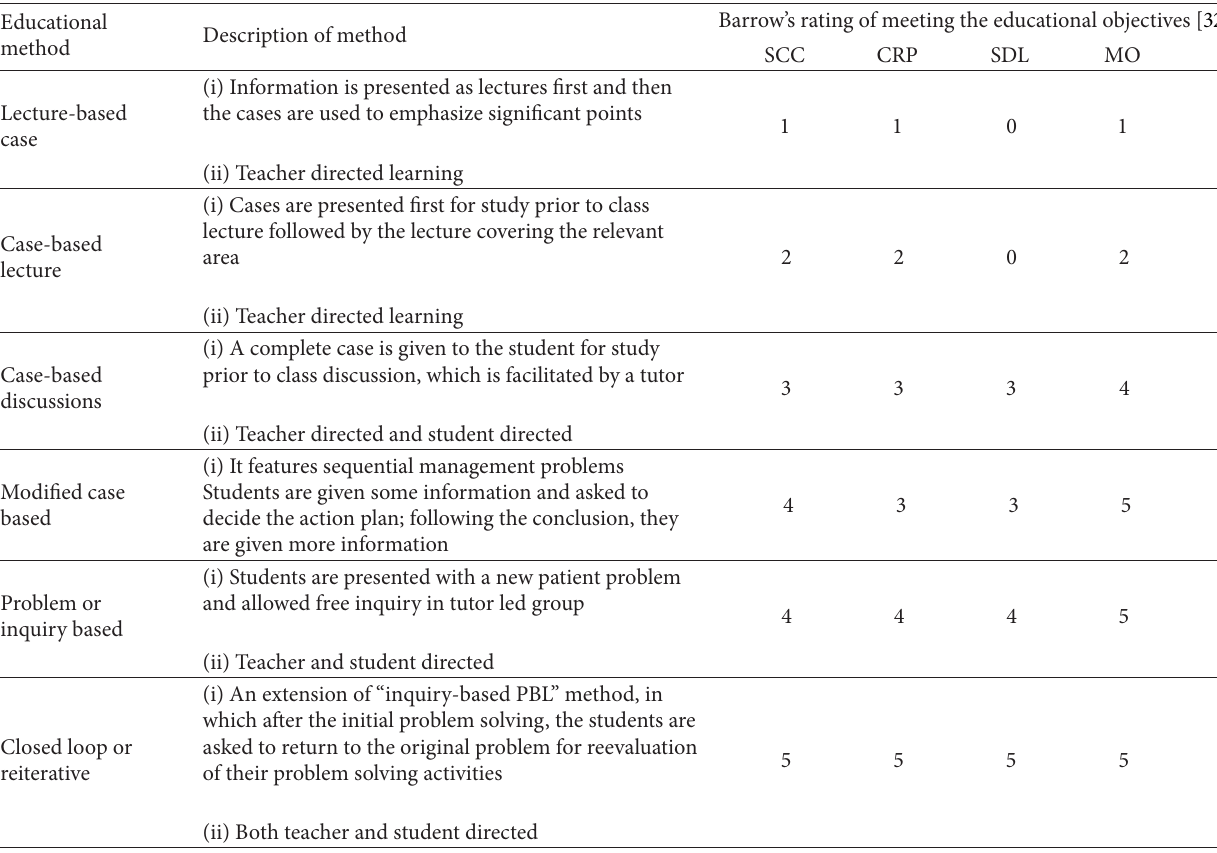
Table 1: Taxonomy of problem-based learning #